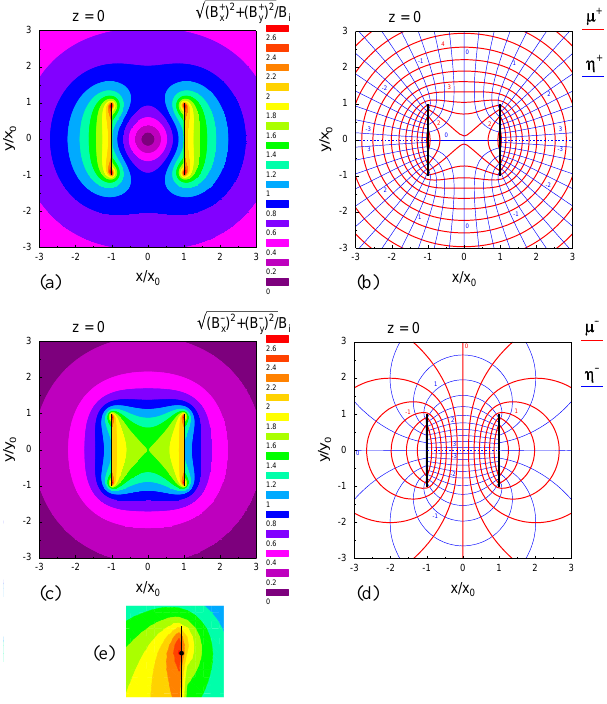
Figure 1. Upper panels: (a) magnetic field magnitude distribution without the ambient field B 0 and (b) the orthogonal coordinates in the z = 0 plane for the parallel case when y 0 = x 0 and y 1 = 0 . 9 y 0 . Middle panels: the same (c) magnetic field magnitude and (d) co- ordinates, for the anti-parallel case. The coordinates µ ± are plotted by thick red lines and the coordinates η ± by thin blue lines. The two thick vertical black lines in each panel, stretching from − 1 to 1, are current sheets. Panel (e) is a magnified part of panel (c) around the right top sheet edge, and it is discussed in Sect.